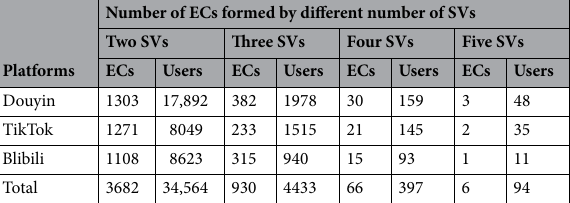
Table 2. Number of ECs (ECs) formed by different short videos (SVs) under different platforms.